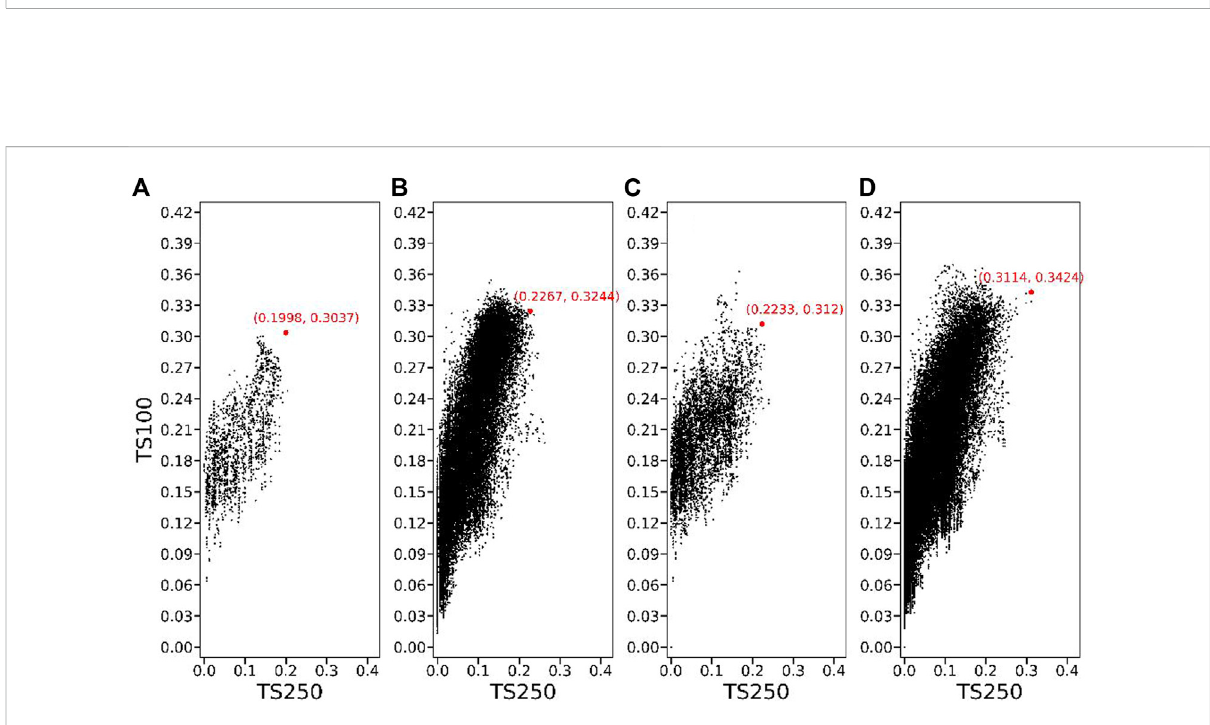
FIGURE 3 Threat scores of (A) DSAEF_A, (B) DSAEF_B, (C) DSAEF_C and (D) DSAEF_D in the accumulated precipitation simulation experiment for 30 training samples, in which each black dot represents a scheme and the red dot indicates the best scheme with the maximum TSsum (TSsum = TS250 +